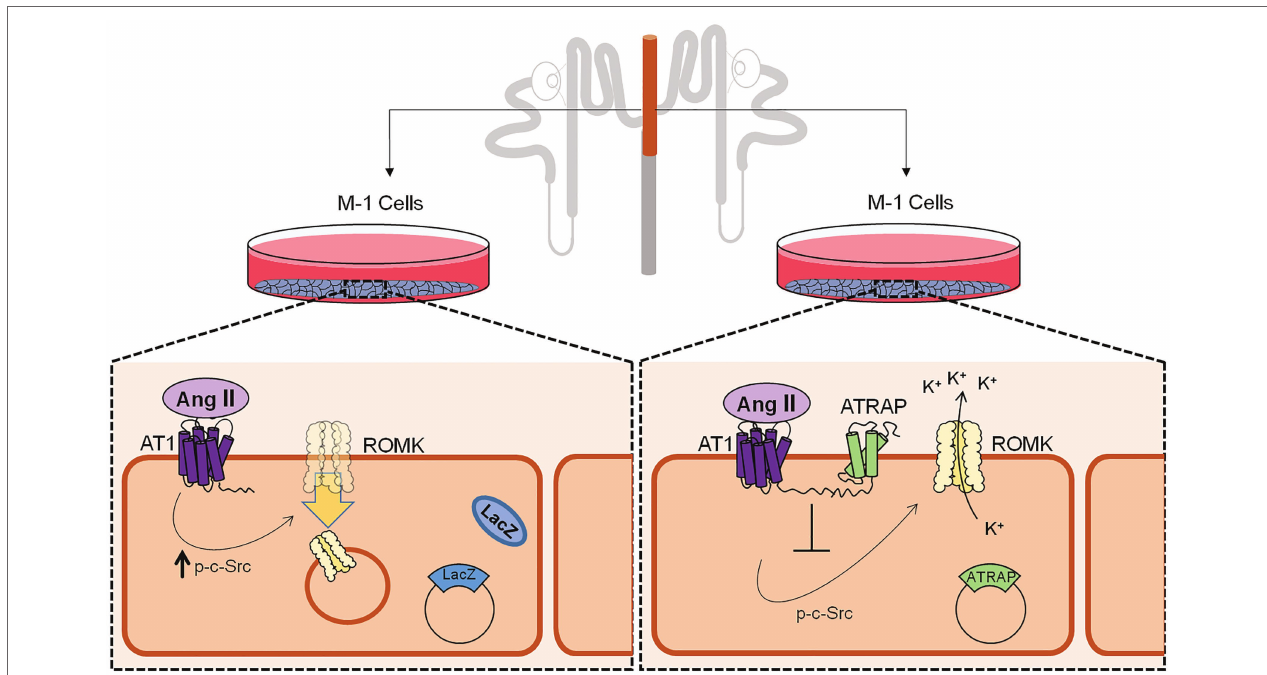
FIGURE 6 | Schematic representation of ATRAP-mediated actions on c-Src phosphorylation status, ROMK expression at the plasma membrane, and ROMK activity. M-1 cells overexpressing control LacZ protein has a decreased K + conductance after Ang II treatment, an effect that was associated with lower expression of ROMK at the plasma membrane and induction of c-Src phosphorylation, the classical signaling pathway for ROMK inhibition by Ang II. Conversely, M-1 cells overexpressing the ATRAP do not show significant decreases in K + conductance after Ang II treatment and plasma membrane ROMK expression, which was also associated with a blunted response of c-Src